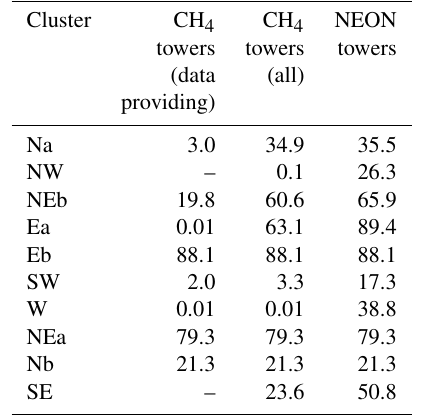
Table 4. The TR cluster for CH 4 towers that are active and providing data to AmeriFlux, the TR cluster for all active CH 4 towers, and the TR cluster for all active towers in addition to NEON